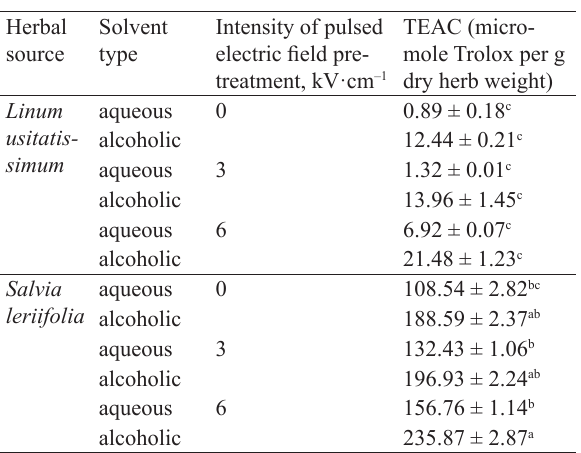
Table 4 Interaction between herbal source, pre-treatment, and solvent type in their effects on antioxidant activity by TEAC